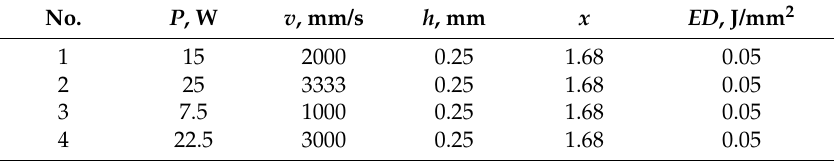
Table 2. Processing parameters with the same value of energy density and overlay ratio.